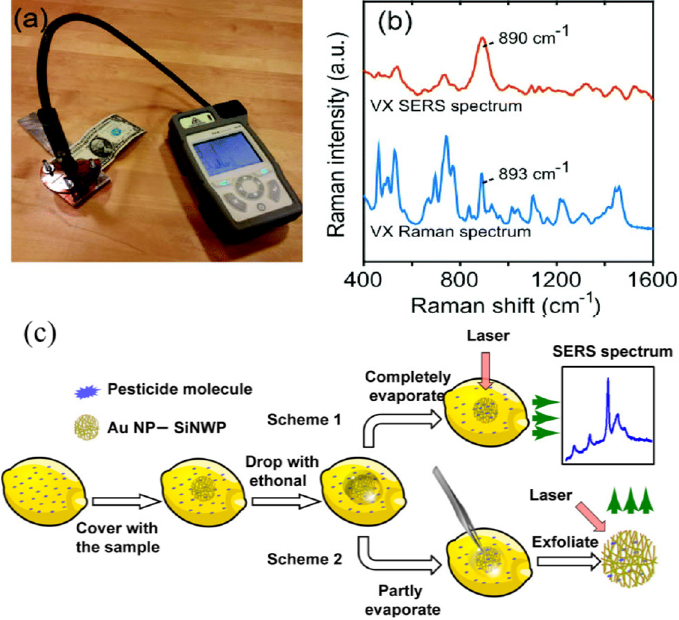
Figure 8. ( a ) The handheld Raman instrument. ( b ) SERS spectrum of 0.75 nmol VX and normal Raman spectrum of > 98% VX solution [12]; ( c ) pathways for the in situ detection of pesticide residues on lemon peels using flexible SiNPs / Au